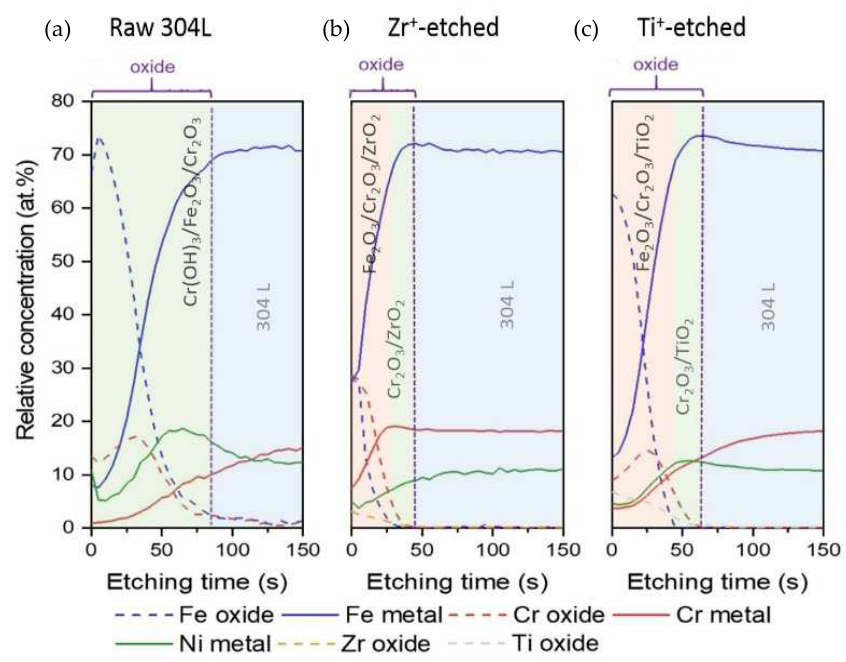
Figure 4. XPS depth profiles of ( a ) raw 304L steel and ( b ) Zr + - and ( c ) Ti + -etched samples.